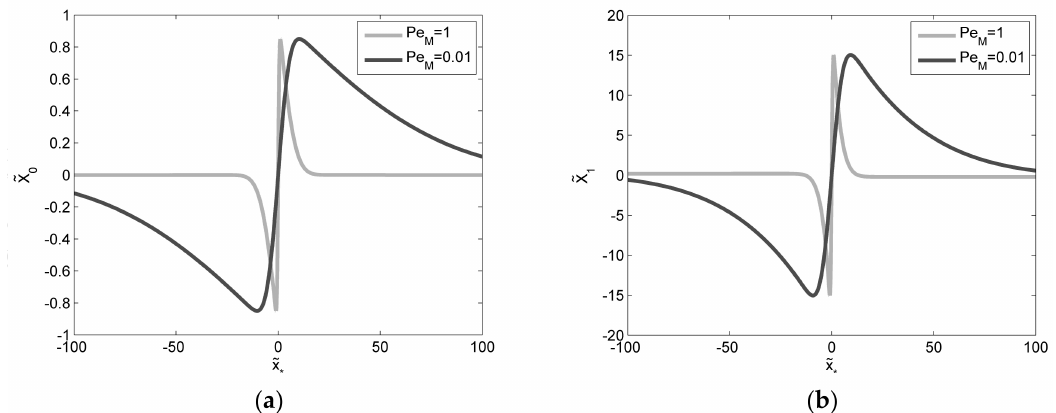
Figure 2. ( a ) Function (cid:102) X 0 for two different macro-Peclet numbers at (cid:101) t = 10; ( b ) Function (cid:102) X 1 for two different macro-Peclet numbers at (cid:101) t = 10.